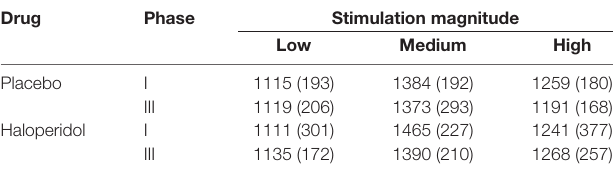
Values represent RTs of correct responses across-subject means in ms